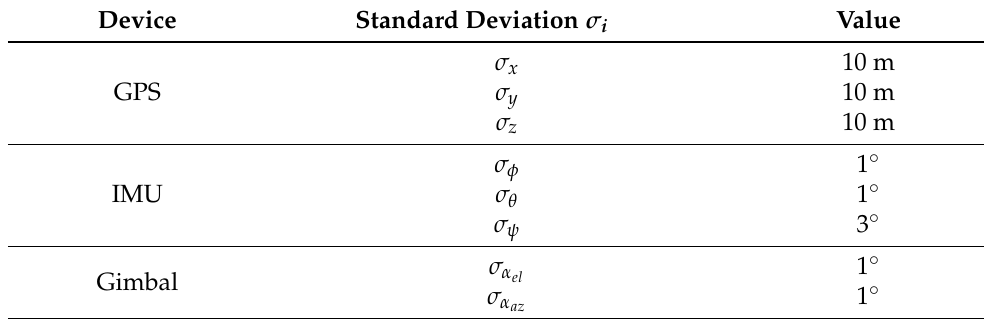
Table 1. GPS, IMU and Gimbal standard